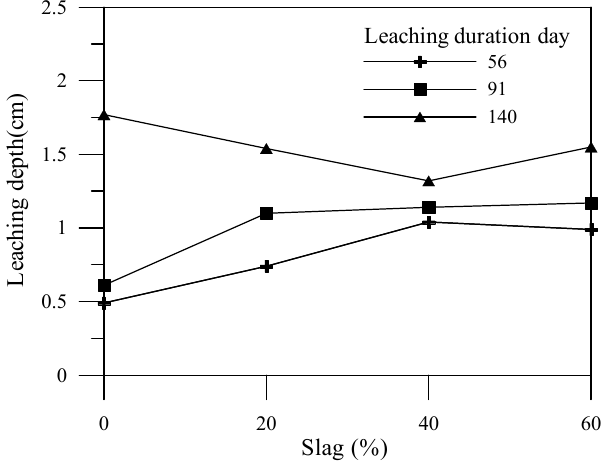
Figure 11. Effects of slag admixture amount on leaching depth and duration.